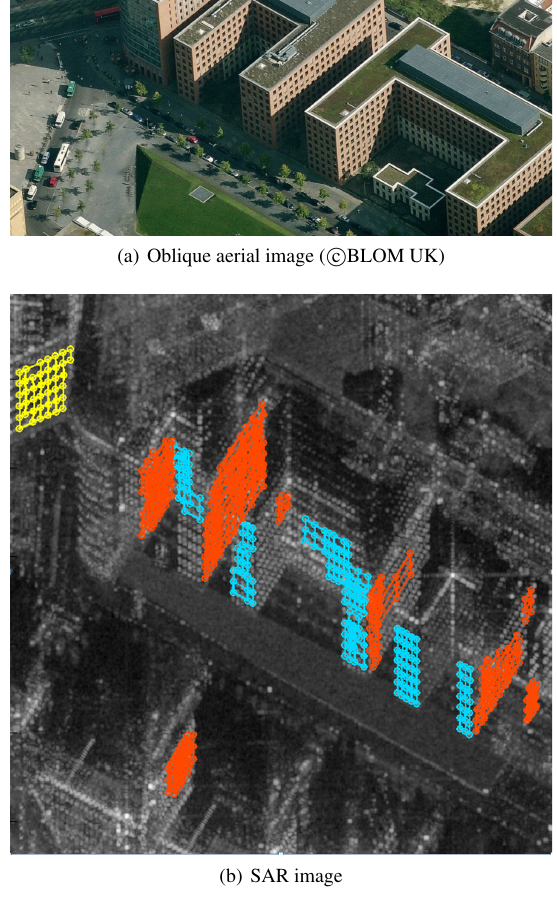
Figure 6: The building complex Park Kolonnaden in Berlin. The SAR image is flipped to facilitate the comparison with the opti- cal image. The color of the lattices code the orientation of the facade’s normal with respect to the sensors line of